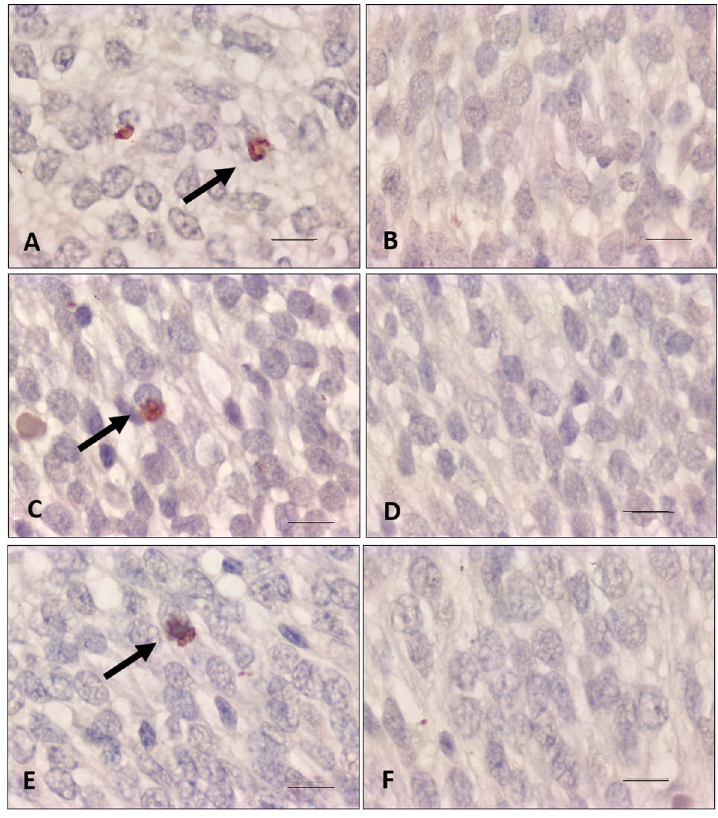
Figure 2. Masson ’ s trichrome staining of collected intestines of newborn rats. Observe slight separation of the lamina propria in the preterm asphyxiated/ventilated rats (PTAV) (score = 1.25; black arrow), desquamation of the villi (gray arrow) and moderate separation of lamina propria in term asphyxiated rats (TA) (score=2.10; white arrow), and slight separation of the lamina propria in term asphyxiated and ventilated rats (TAV) (score=1.57) (red arrow); n=4. PTC: preterm control; PTV: preterm ventilated; PTA: preterm asphyxiated; TC: term control; TV: term ventilated. Magni fi cation: 200 (cid:1) ; scale bar: 50 m m.